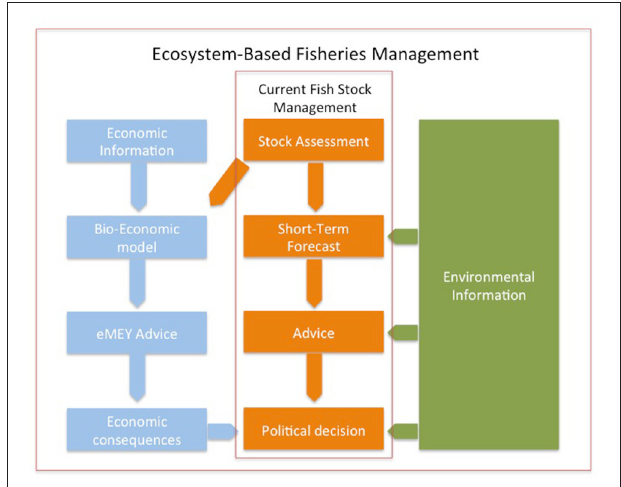
FIGURE 4 | Incorporation of ecological-economic modeling and environmental information in the standard advice process to proceed to a more integrated advice, and ecosystem-based fisheries